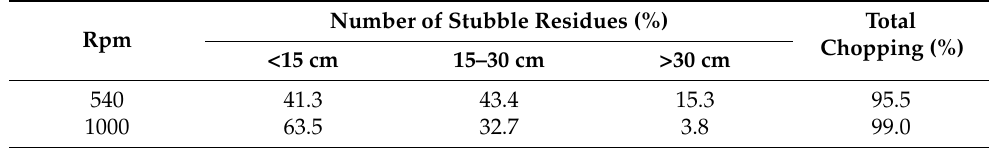
Table 3. Chopping quality of sunflower